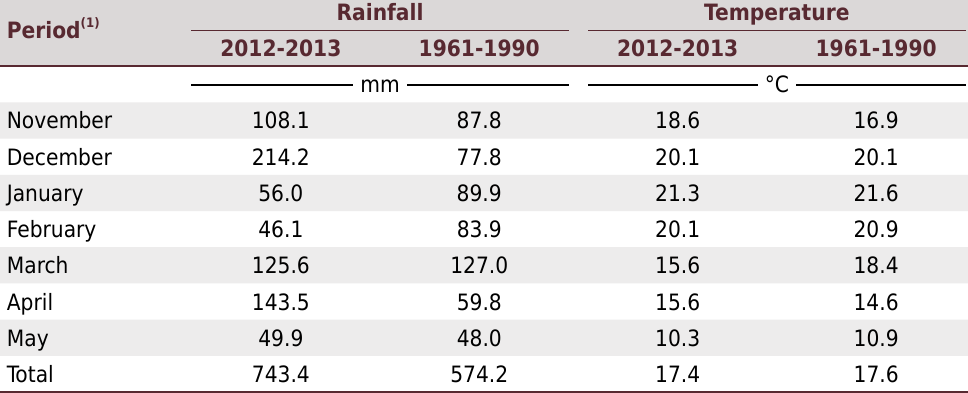
Table 3. Average air temperature and total rainfall received for the month during the soybean production